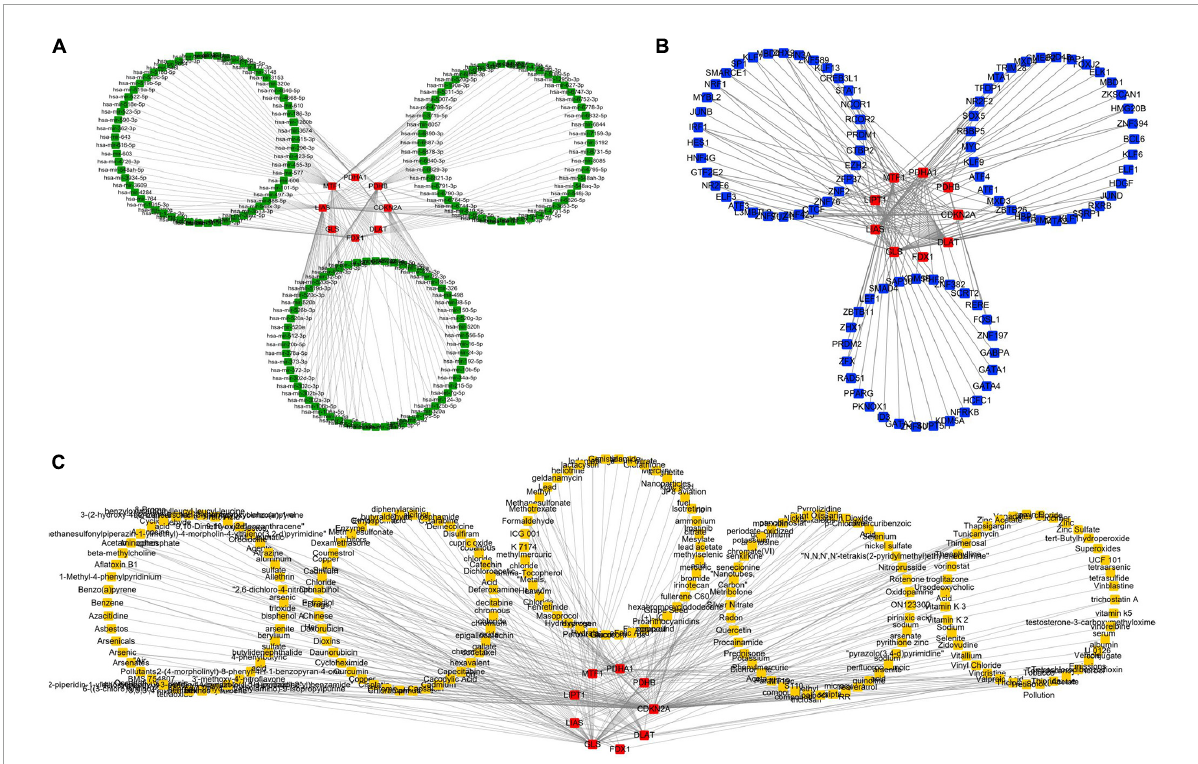
FIGURE5 Regulatory mechanism of cuproptosis-related genes (CRGs). (A) The competing endogenous RNA (ceRNA) network of CRGs. (B) The TF network of CRGs. (C) The chemicals network of CRGs (Red nodes represent CRGs, green nodes represent miRNAs, blue nodes represent TF, and yellow nodes represent